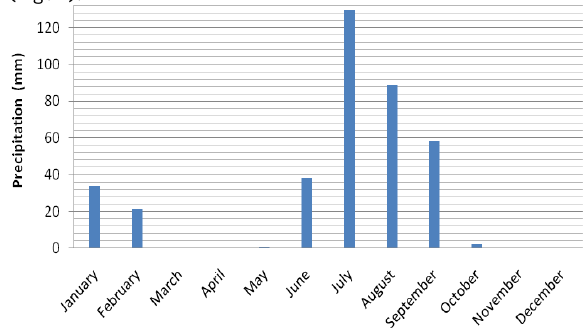
Fig. 2. Monthly Rainfall (mm) in Jodhpur ( Source: IMD,